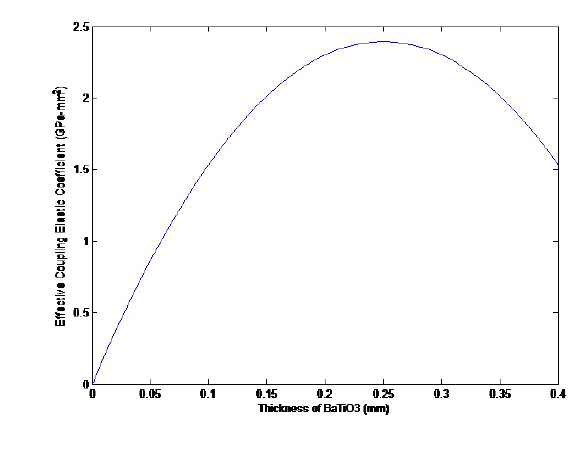
Figure 3: Plot of effective ⟨︀ zb 11 11 ⟩︀ coupling coeflcient vs. thickness of the BaTiO 3 laminae.